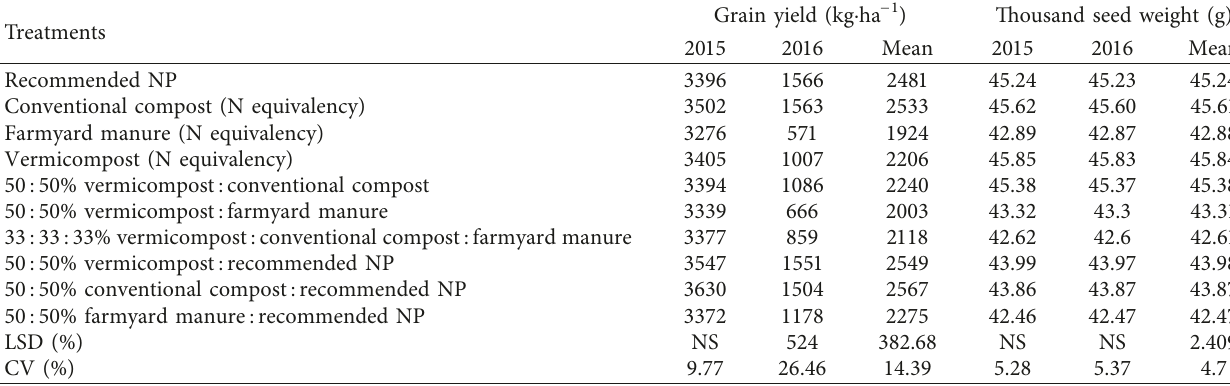
Table 2: Effects of the integrated use of organic and inorganic fertilizers on grain yield and thousand seed weight of barley in 2015-2016 cropping seasons on smallholder farmers’ fields in Chelia district. Treatments Recommended NP Vermicompost (N